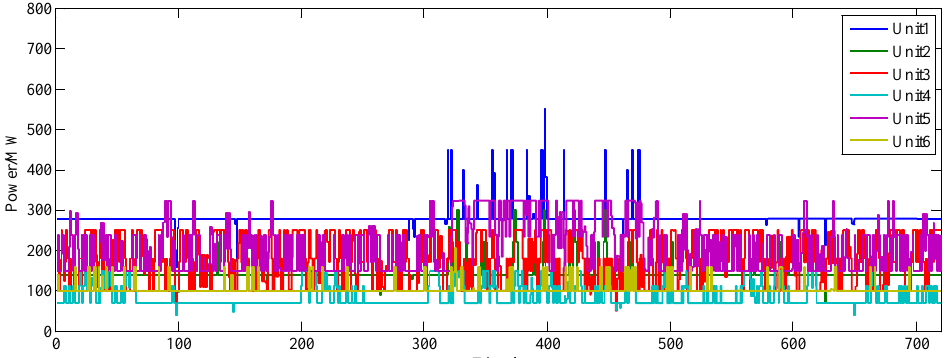
Figure 6. The hourly power output curve of each thermal power unit in April.